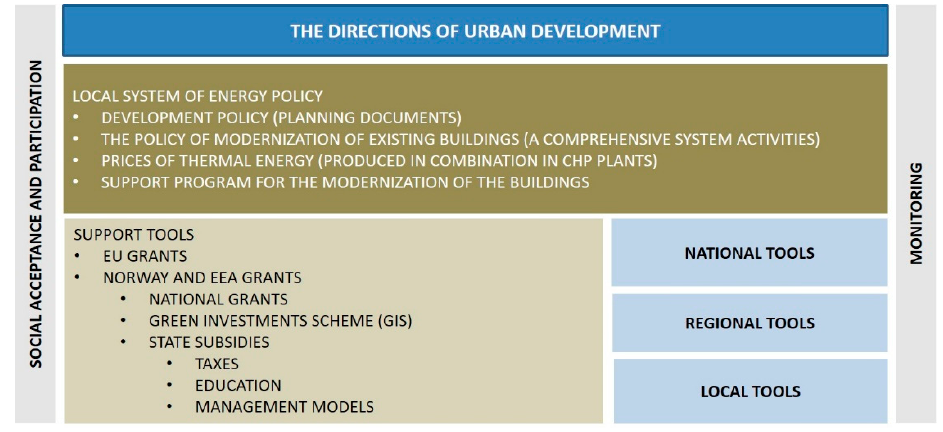
Figure 7. A local policy model, based on social, economic and technical data to improve the energy efficiency of buildings.